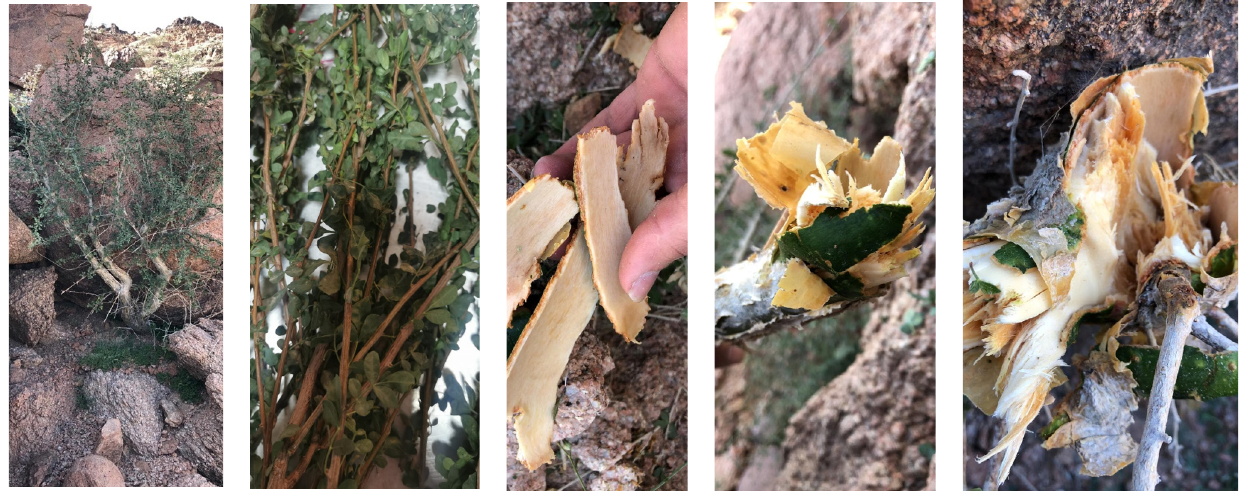
Figure 2. Photos of the plant, harvested in Badr, Medina district, Saudi